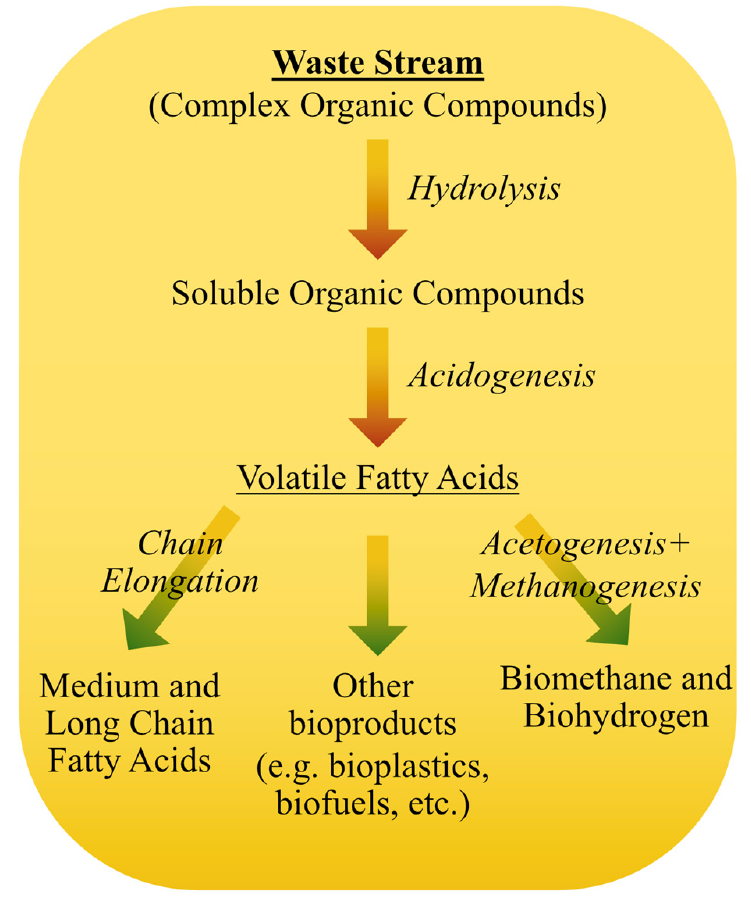
Figure 2. Summarization of anaerobic digestion processes with the emphasis on product type .